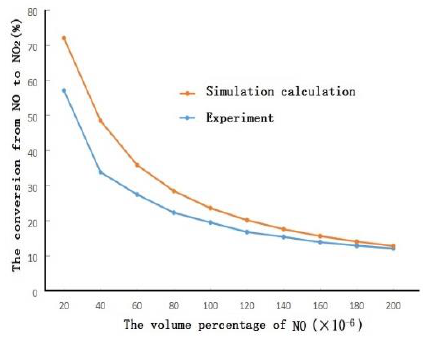
Figure 9. Effect of NO concentration on the conversion.